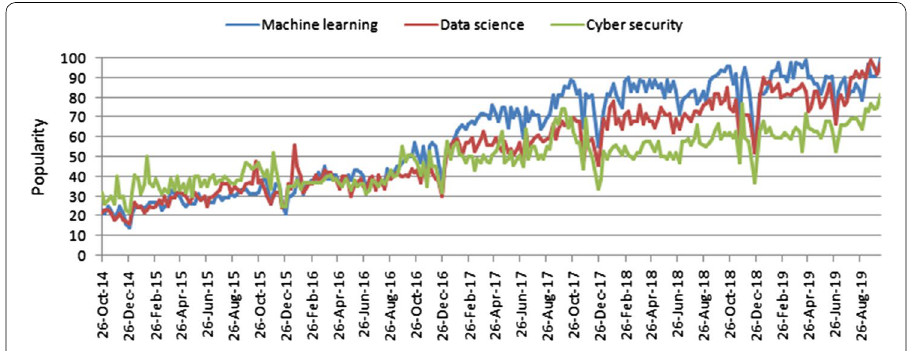
Fig. 1 Popularity trends of data science, machine learning and cybersecurity over time, where x-axis represents the timestamp information and y axis represents the corresponding popularity